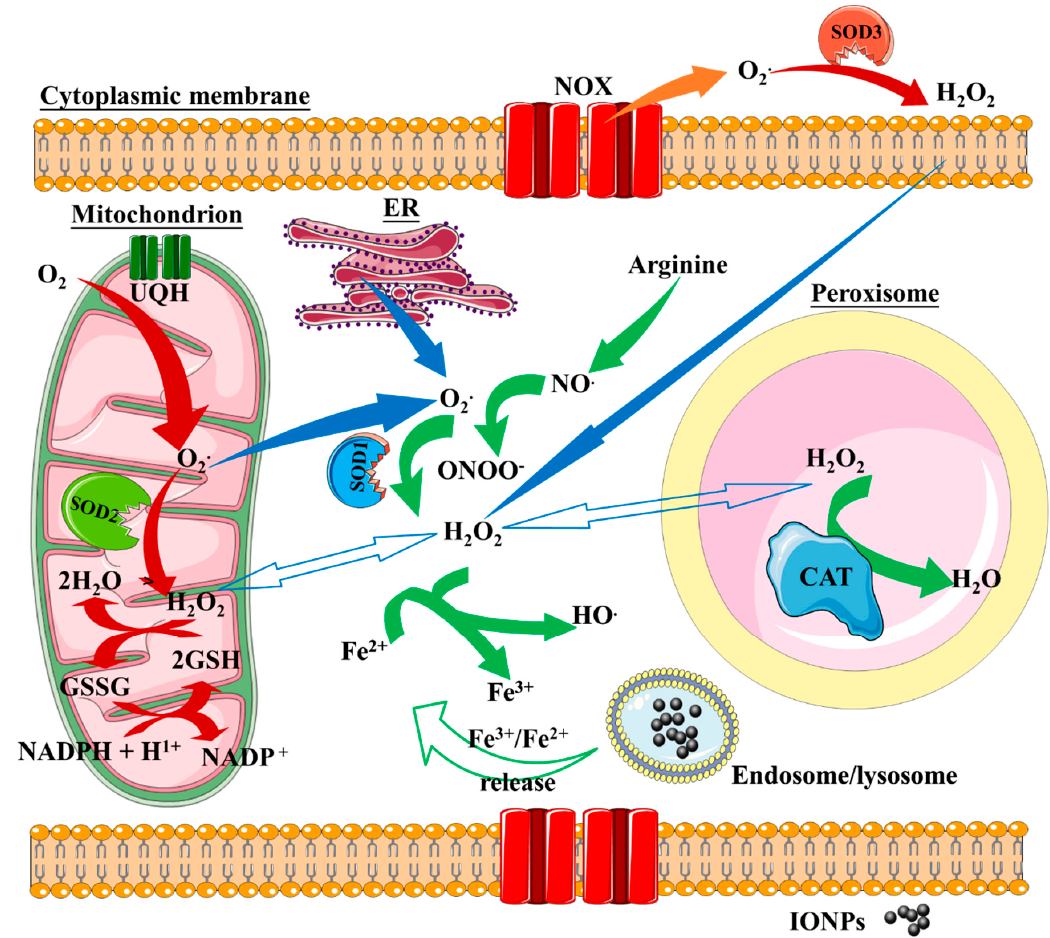
Figure 3. Overview of intracellular ROS metabolism and involvement of iron through the Fenton reaction. H 2 O 2 arises from intracellular sources via the activity of cytoplasmic SOD1, mitochondrial SOD2, and peroxisome molecular machinery. Extracellular H 2 O 2 is generated by extracellular SOD3. H 2 O 2 production is central to the production of ROS by iron cations through the Fenton reaction. Iron cations released from IONP cores drive H 2 O 2 to split into hydroxyl anion (HO − ) and the more reactive hydroxyl radical ( • OH). SOD, superoxide dismutase; CAT, catalase; UQH, reduced ubiquinone; GSH and GSSG, reduced and oxidized glutathione, respectively; NOX, NADPH oxidase; ER, endoplasmic